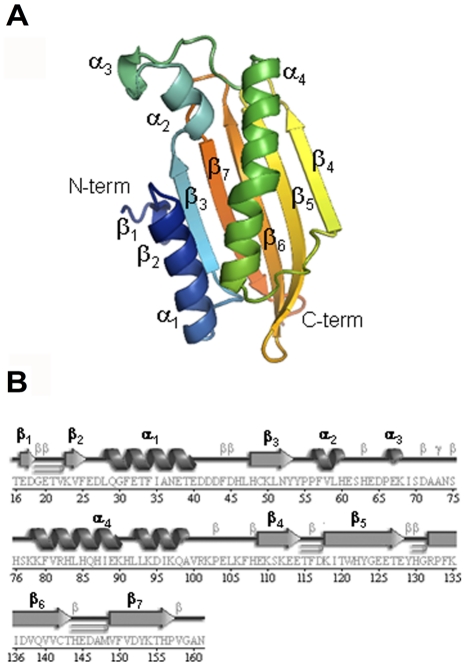
Crystal structure of 11V-161NYer067w protein.(A) Ribbon diagram of Yer067w color-coded from the N-terminus (blue) to C-terminus (red). Alpha-helices (α1-α4) and beta-strands (β1-β7) are labeled. (B) Secondary structure elements in Yer067w superimposed on its primary sequence. Beta and gamma-turns are denoted as β and γ, respectively. Beta-hairpins are shown as ⊃. The secondary structure diagram was generated by PDBsum.